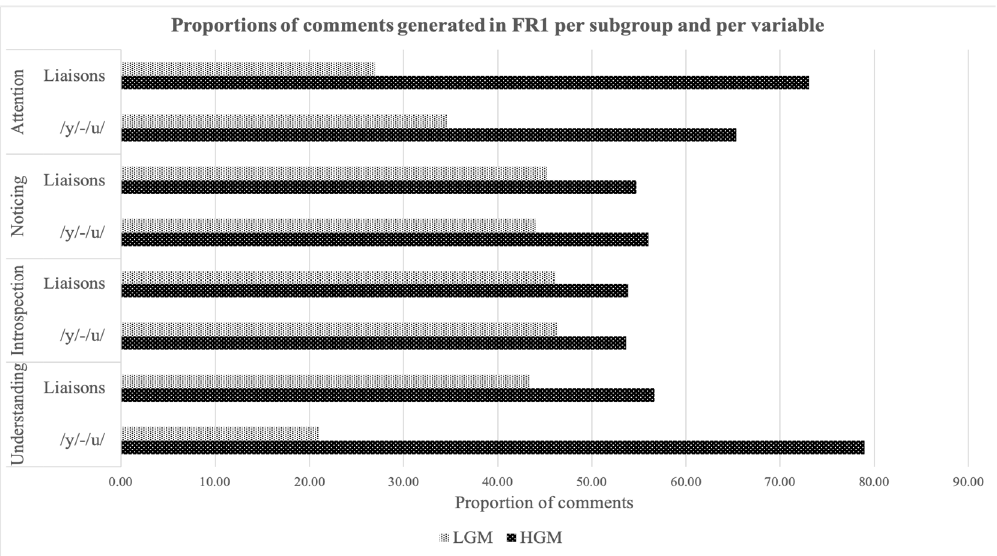
Figure 3. Proportions of comments generated in FR1.